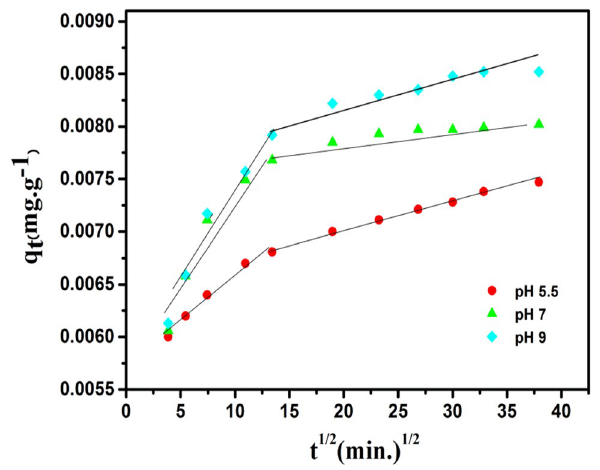
Fig. 7 The plot of intra-particle diffusion for different values of pH